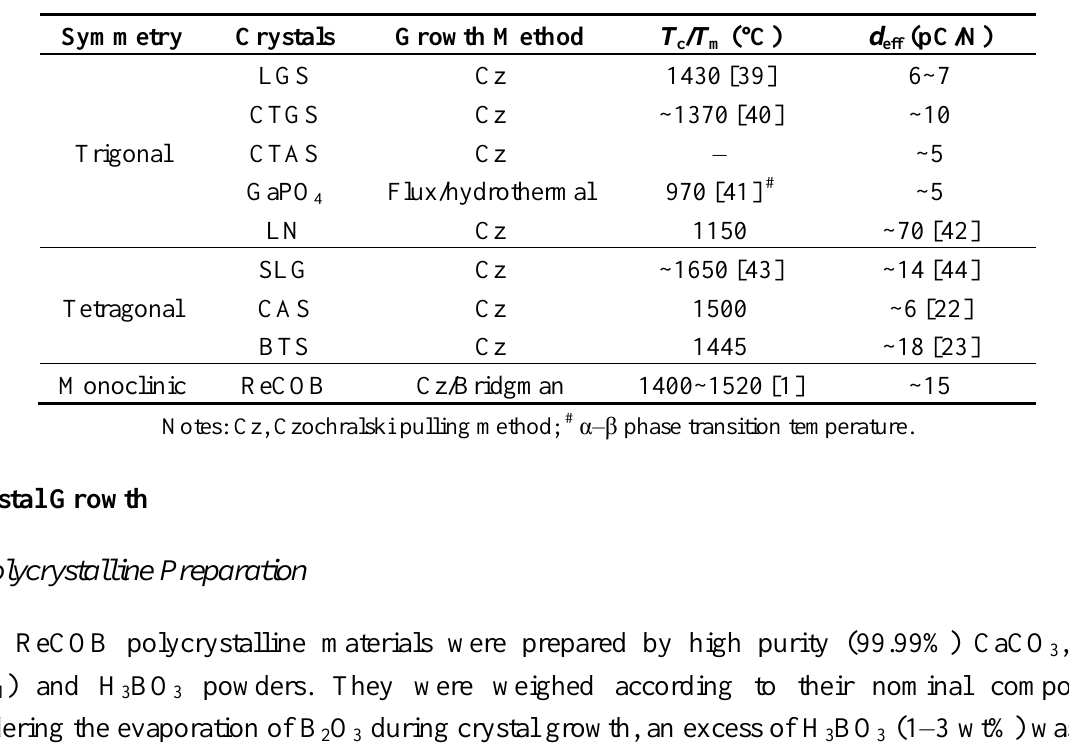
TaGa Si O ; CTAS, Ca 3 3 2 14